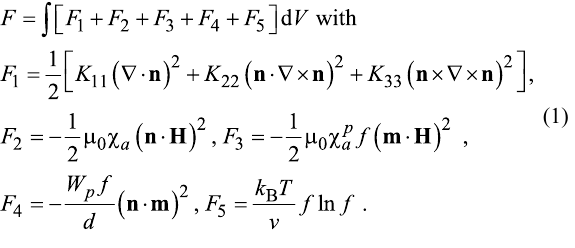
In the framework of continuum theory, the equilibrium state of the suspension corresponds to the minimum of free